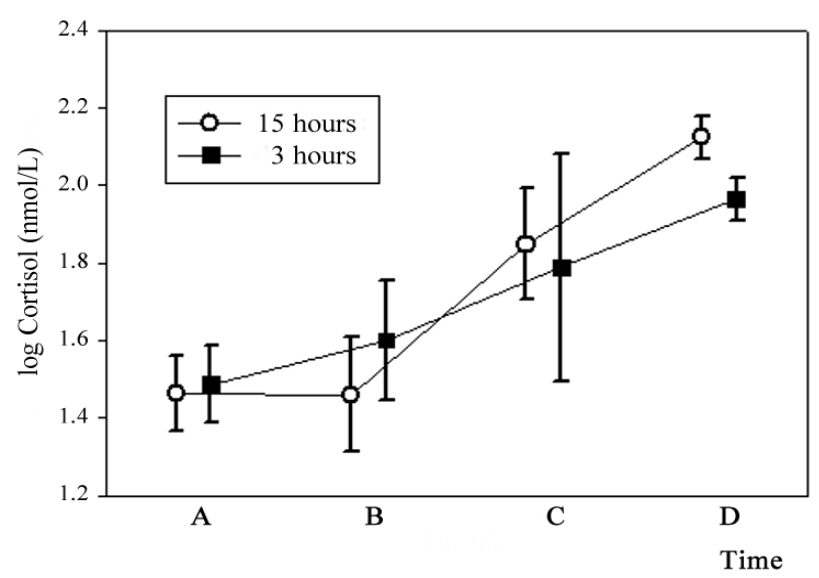
Figure 1. Serum cortisol (log) values at different times within each slaughter group. Lines represent media and confidence interval. Time A: farm basal value; Time B: after transport; Time C: after lairage; Time D: at slaughter.